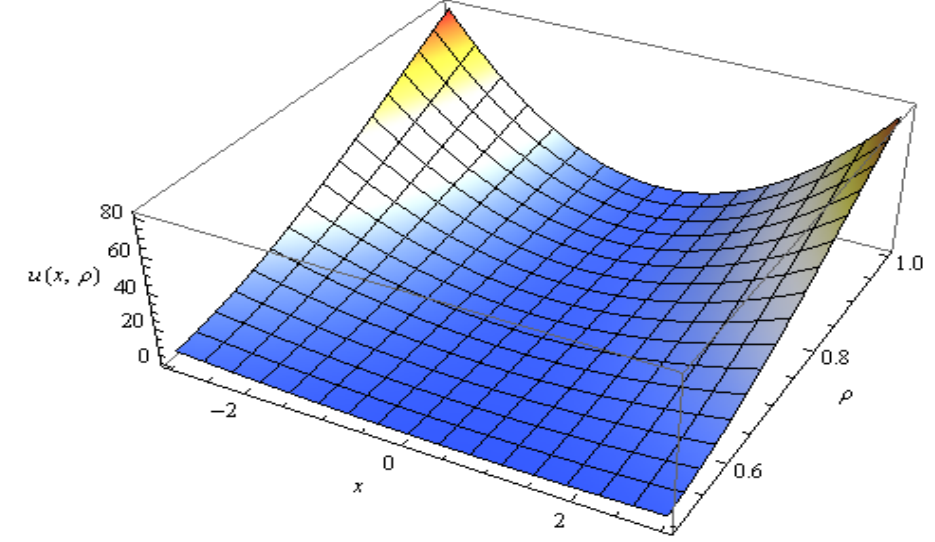
Figure 7. Solution of Equation (11) when ϕ = 0.99 and t = 0.3.